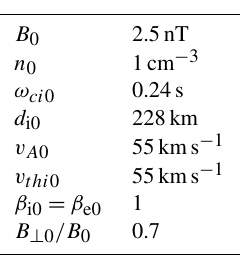
Table 2. Initial parameters of the decaying turbulence